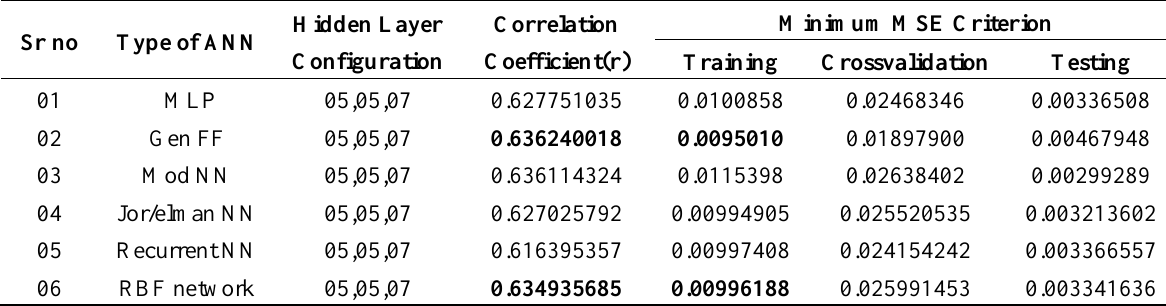
Table 2. Comparison of different types of Neural network